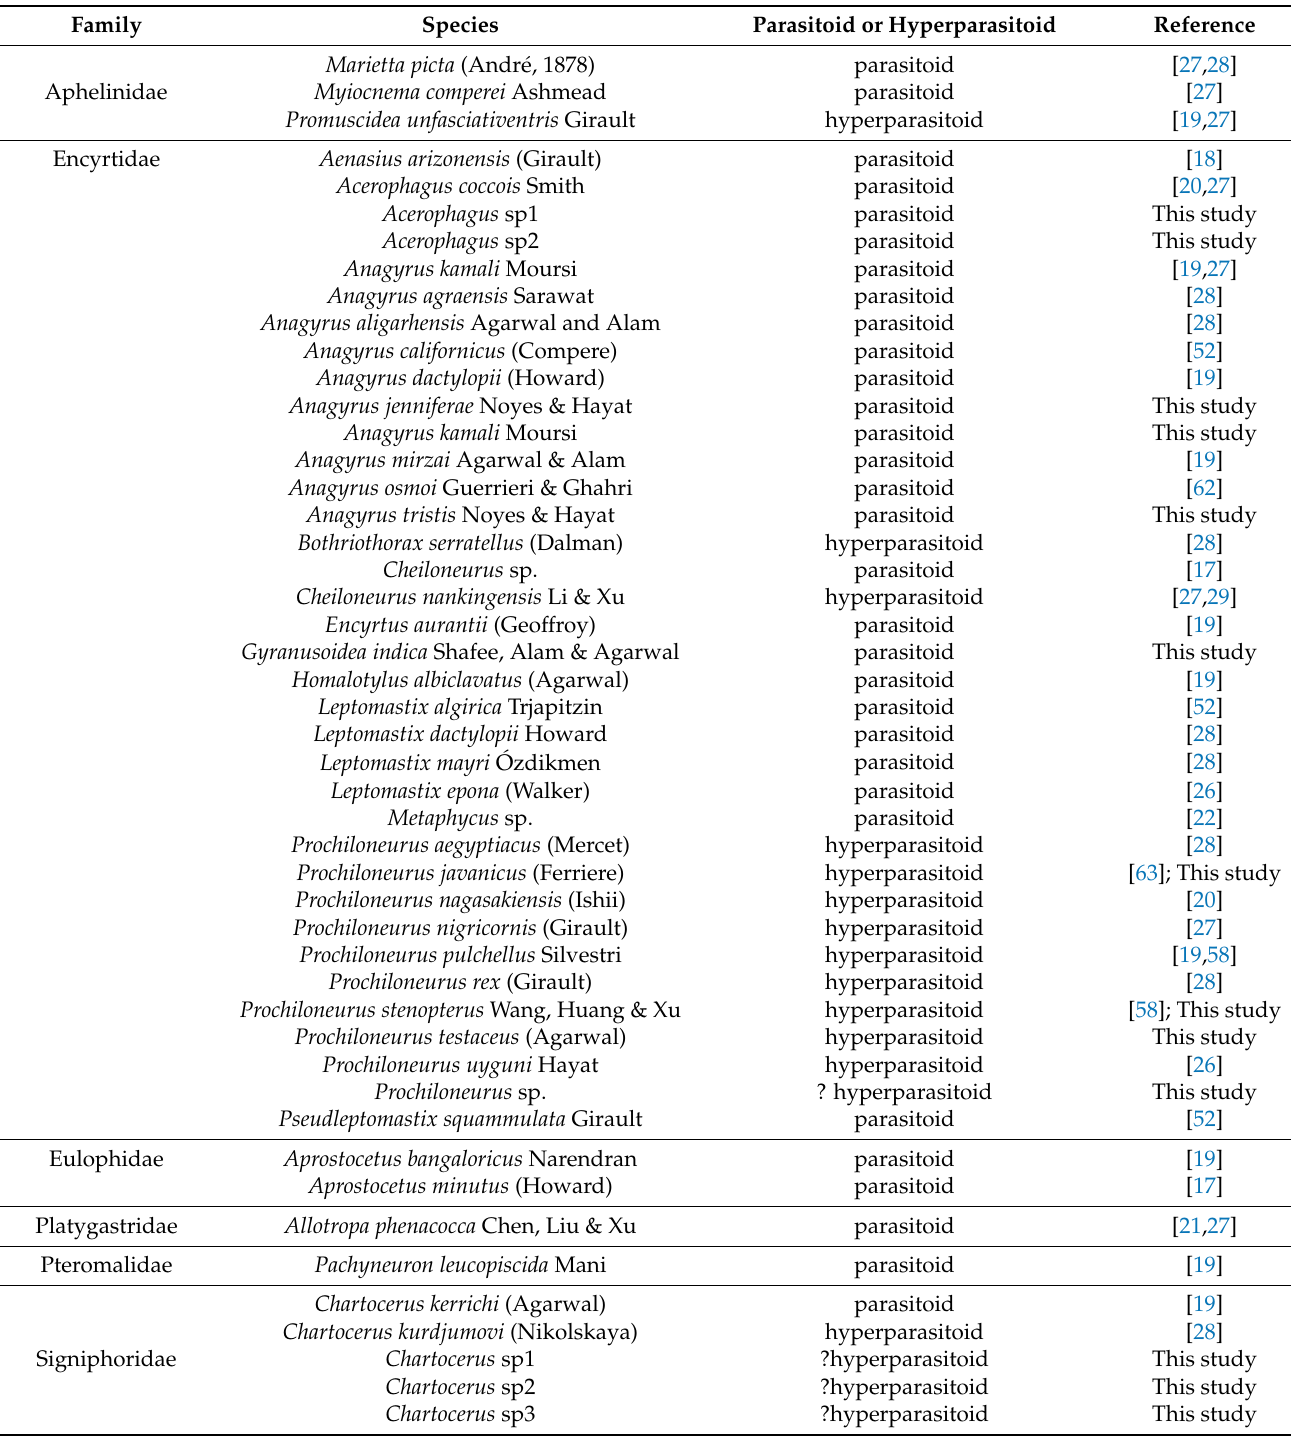
Table 1. Hymenoptera parasitoids associated with P. solenopsis (the symbol “?” indicates that the biology is uncertain).